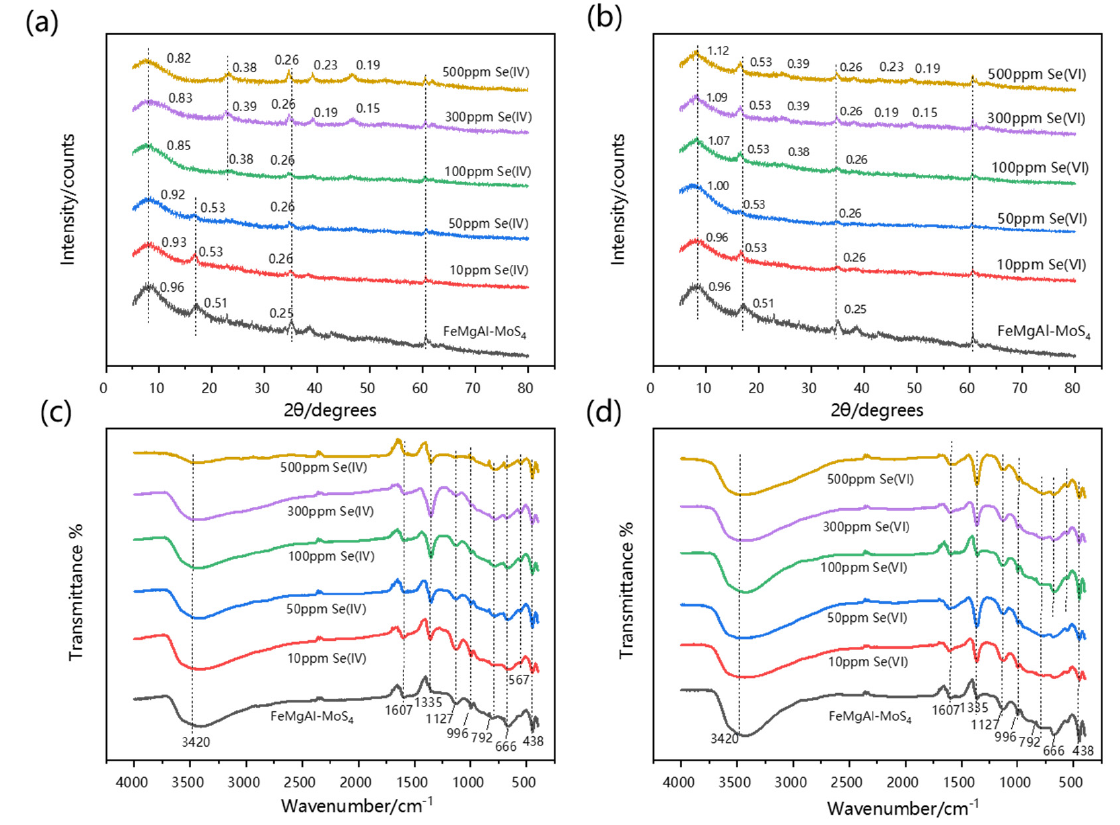
Figure 3. XRD patterns of Se(IV) ( a ), and Se(VI) ( b ) for different concentrations after adsorption by FeMgAl − MoS 4 ; IR spectra of s after FeMgAl − MoS 4 adsorbed Se(IV) ( c ), and Se(VI) ( d ) at different concentrations.